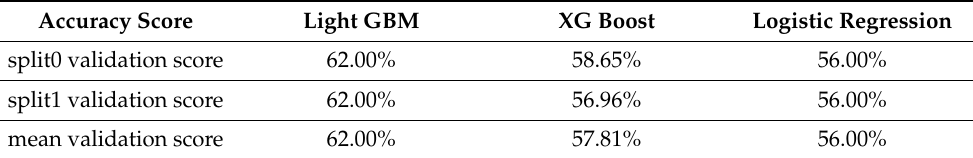
Table 6. Validation results from weekly models. Numbers are truncated to four decimal places or two decimal places in percent